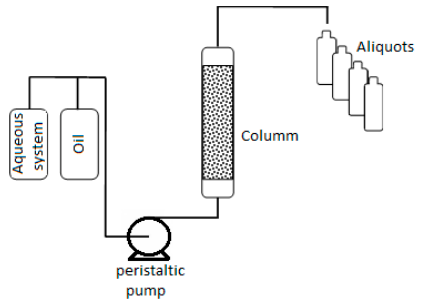
Figure 2. Oil displacement set-up scheme.